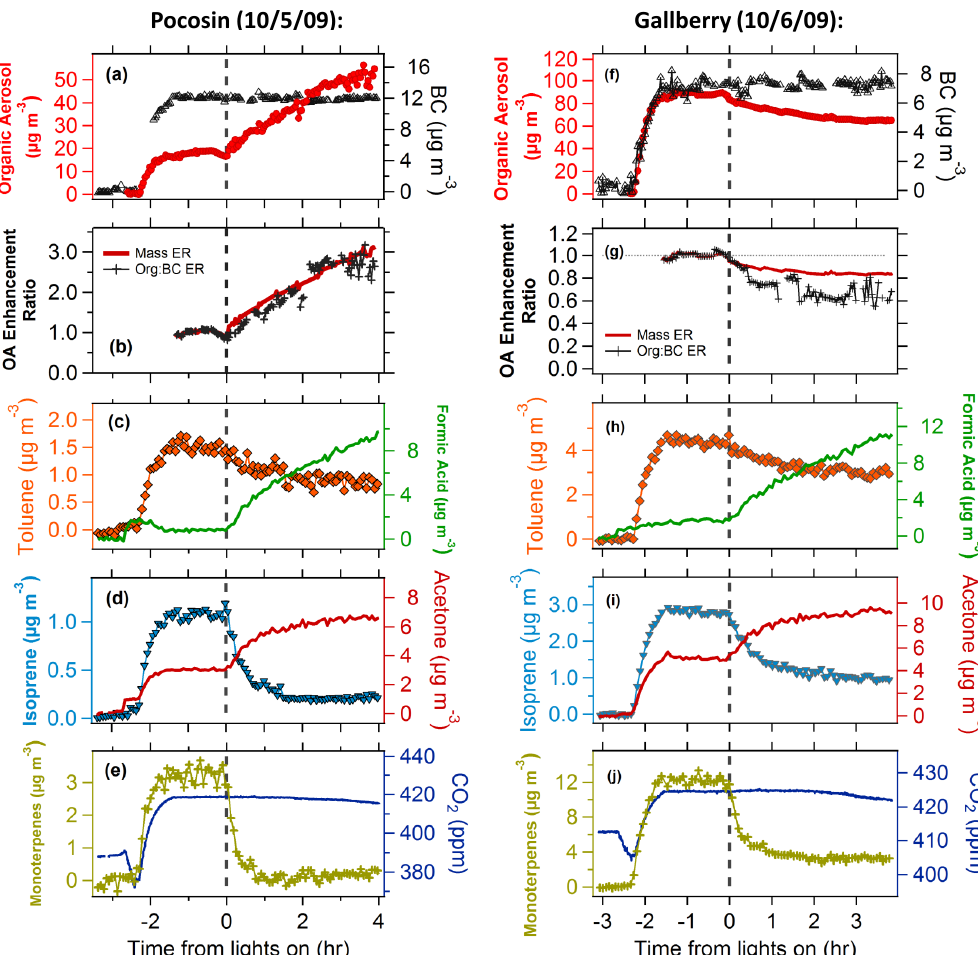
Fig. 2. Measured time series of gas and particle species in experiments where significant OA production was observed (Burn 63, pocosin, panels a – e ) and where a net loss of OA mass with aging was observed (Burn 65, gallberry, panels f – j ). (a) , (f) Wall-loss-corrected OA and BC concentrations. (b) , (g) OA mass enhancement ratios calculated using the OA-to-BC ratio and the first-order wall loss rate constant. (c) , (h) Toluene and formic acid concentrations measured by the PTR-MS. (d) , (i) Isoprene and acetone concentrations measured by the PTR-MS. (e) , (j) Monoterpene concentrations estimated using the m/z 81 signal in the PTR-MS and CO 2 levels. Note, isoprene concentrations were likely influenced by furan, which is also detected in the PTR-MS at m/z 69 (Warneke et al.,